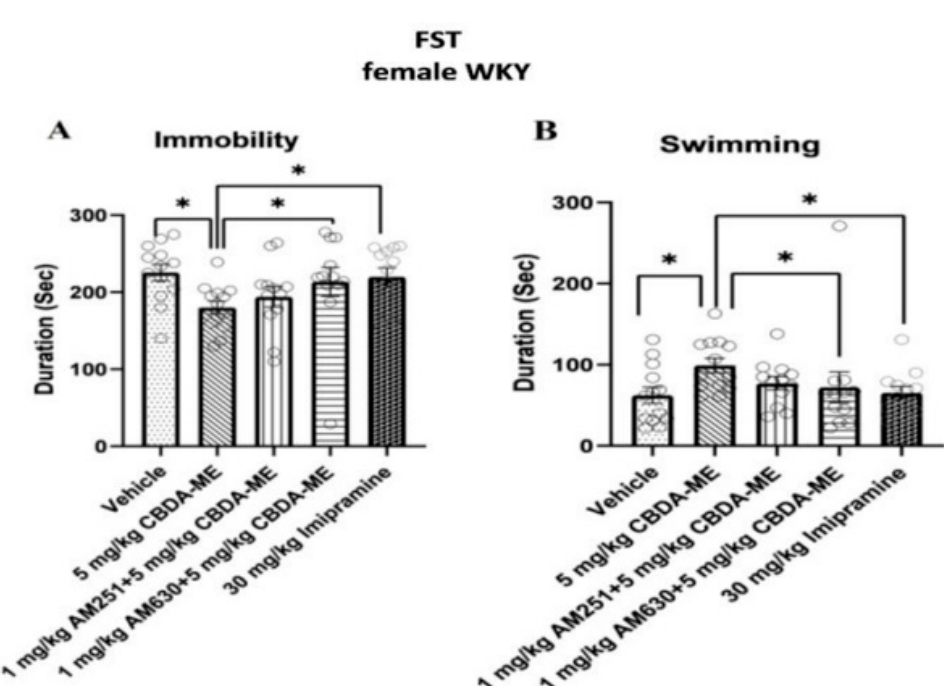
Figure 5. ( A ) Duration of immobility of female WKY rats ( B ) duration of swimming (mean + SEM) of female WKY rats. Rats received either vehicle (n = 13) or 5 mg/kg CBDA-ME (n = 13), 1 mg/kg AM251 + 5 mg/kg CBDA-ME (n = 12), 1 mg/kg AM630 + 5 mg/kg CBDA-ME (n = 12), 30 mg/kg Imipramine (n = 12). * p < 0 .05.